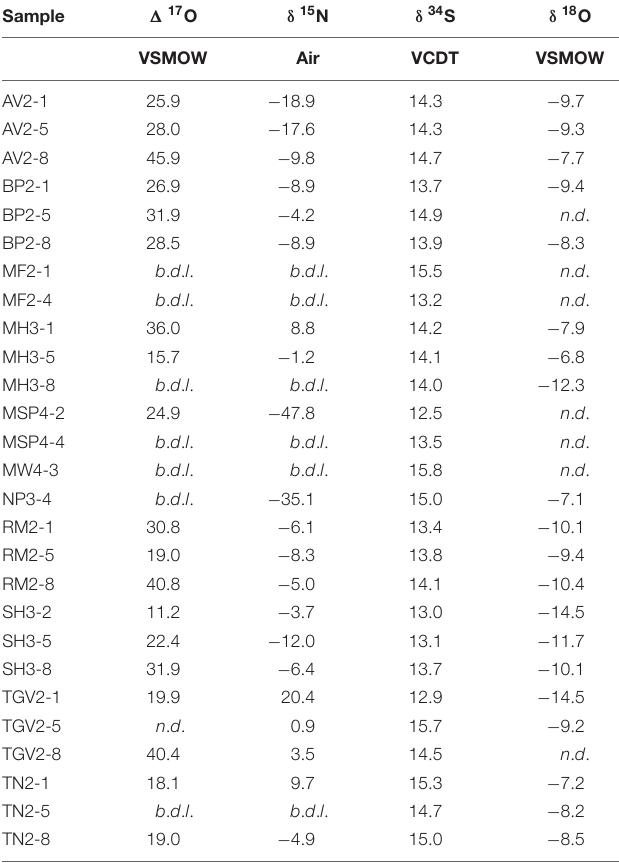
TABLE 2 | δ 15 N and (cid:49) 17 O of NO 3 − and δ 34 S and δ 18 O of SO 42 −